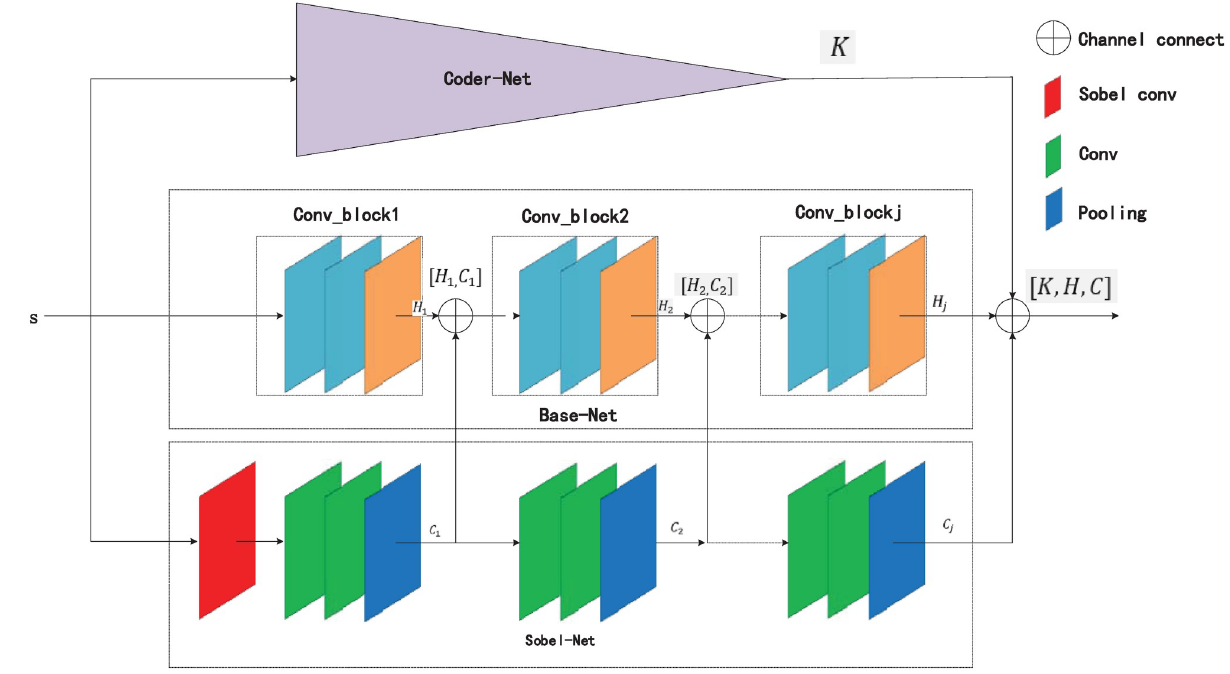
Fig 4. E-A-Net network